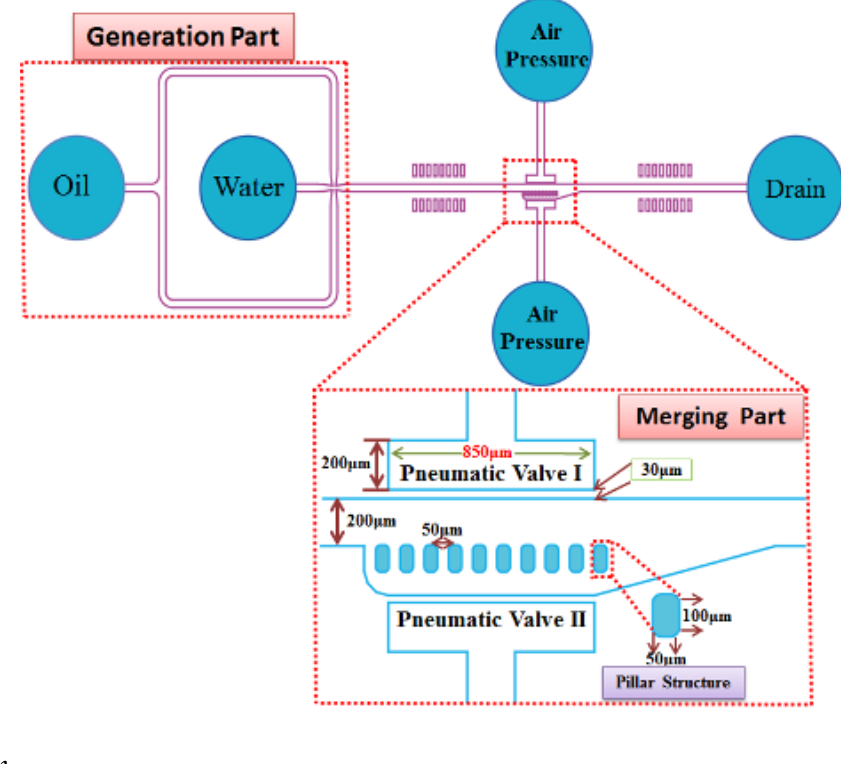
Figure 2. Schematic illustration of the microfluidic active merging device. The merging part is 300 µm in width and divided in two channels (side channel = 100 µm & main channel = 200 µm) with the one pillar